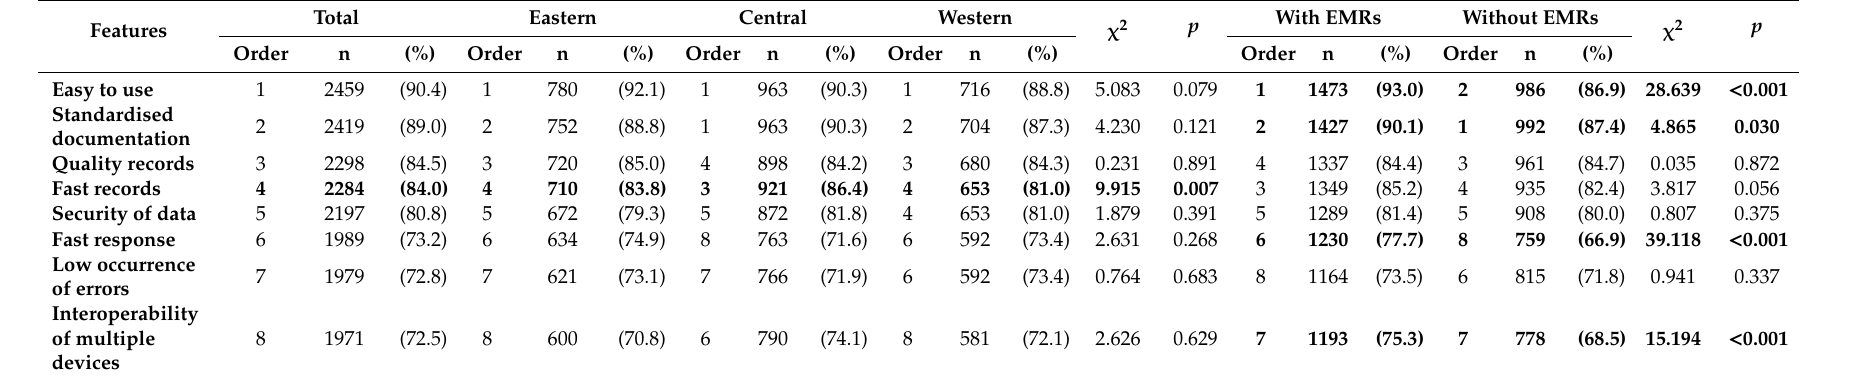
Table 5. Preferred features of usability of electronic medical records ( n =